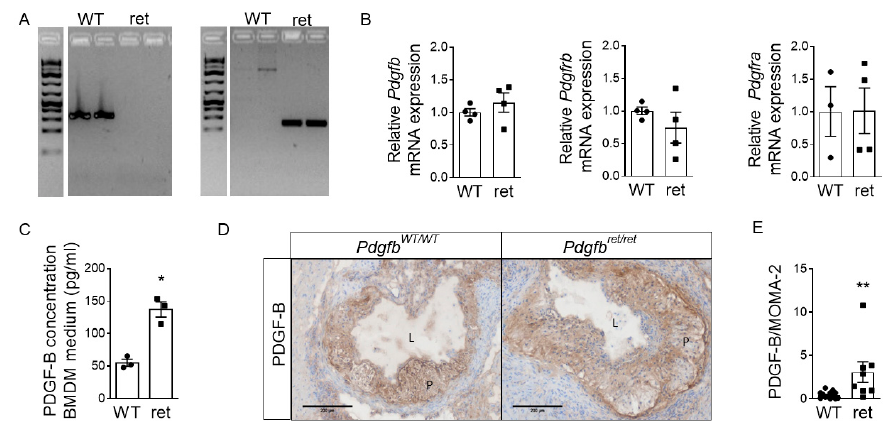
Increased secretion of soluble PDGF-B by Pdgfb ret / ret BMDMs. ( A ) Gel imaging after DNA genotyping. PCR product Pdgfb WT 340 bp (left) and Pdgfb ret 212 bp (right). ( B ) Pdgfb , Pdgfrb and Pdgfra mRNA expression in Pdgfb ret / ret relative to Pdgfb WT / WT BMDMs ( n = 4). ( C ) PDGF-B concentration in Pdgfb WT / WT and Pdgfb ret / ret BMDM-derived medium as assessed by ELISA ( n = 3). ( D ) Representative photomicrographs of PDGF-B staining in Pdgfb WT / WT and Pdgfb ret / ret aortic root lesions. P; plaque, L; lumen. ( E ) Quantification of total PDGF-B plaque area relative to the total MOMA-2 plaque area in the adjacent sections of Pdgfb WT / WT ( n = 13) and Pdgfb ret / ret ( n = 8) aortic root lesions. Graphs represent mean ± SEM. * p < 0.05, ** p < 0.01. Scale bars 200 μ m. Data were tested for normality (Shapiro-Wilk) and equal variances (F-test). Variables that did or did not pass were analyzed using Student’s t -test or the Mann-Whitney U test, respectively. Data in C were transformed to ranks followed by a Student’s t -test.